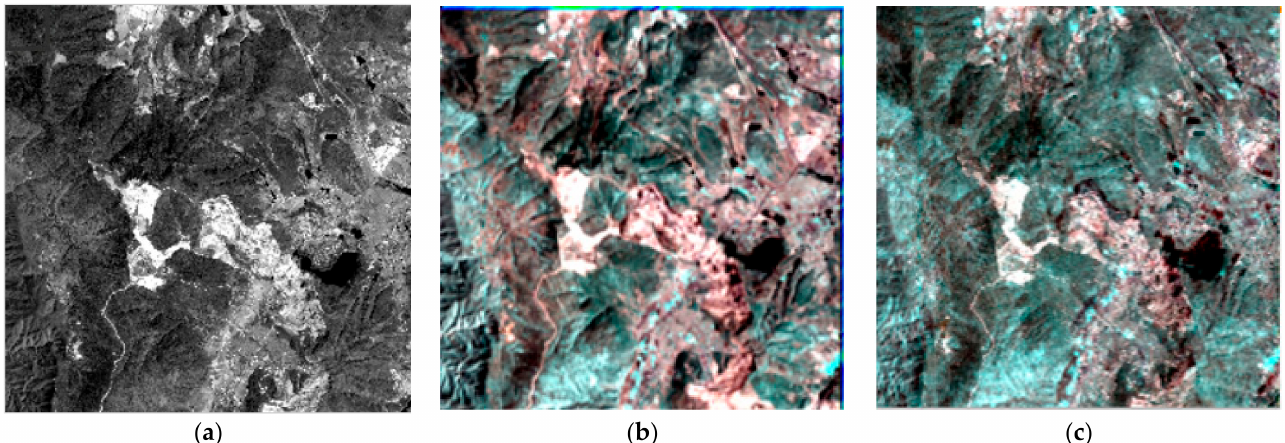
Figure 5. The Dianchi dataset: ( a ) Panchromatic image, ( b ) RGB image of hyperspectral data and ( c ) RGB image of ground truth